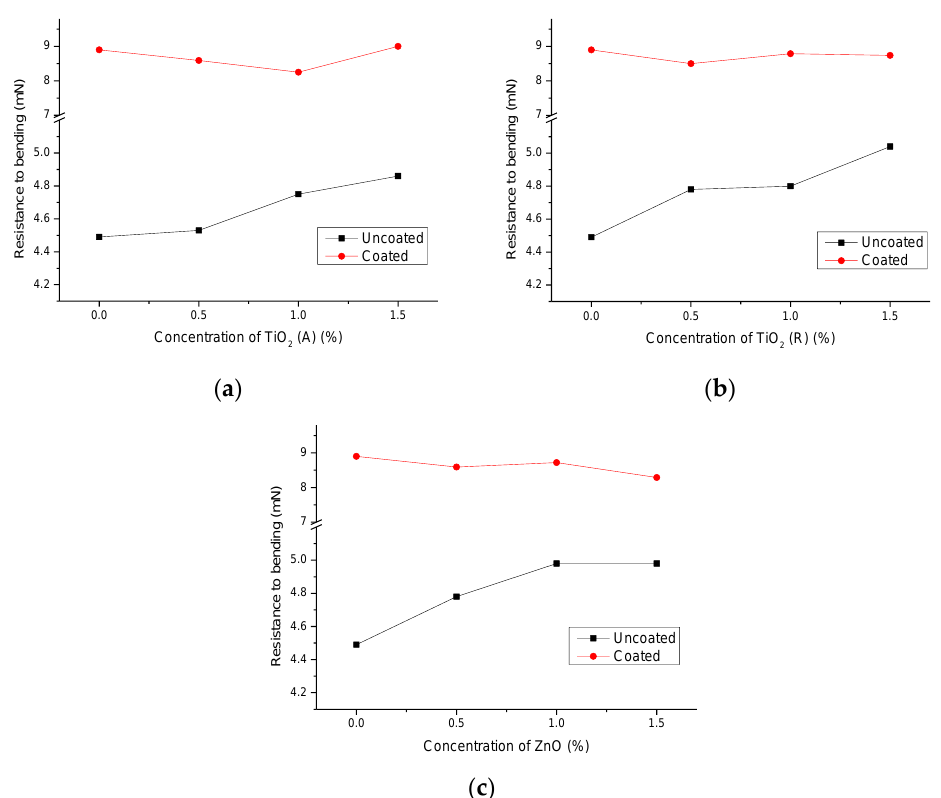
Figure 5. Resistance to bending of uncoated and coated paperboards with deposited thin films and